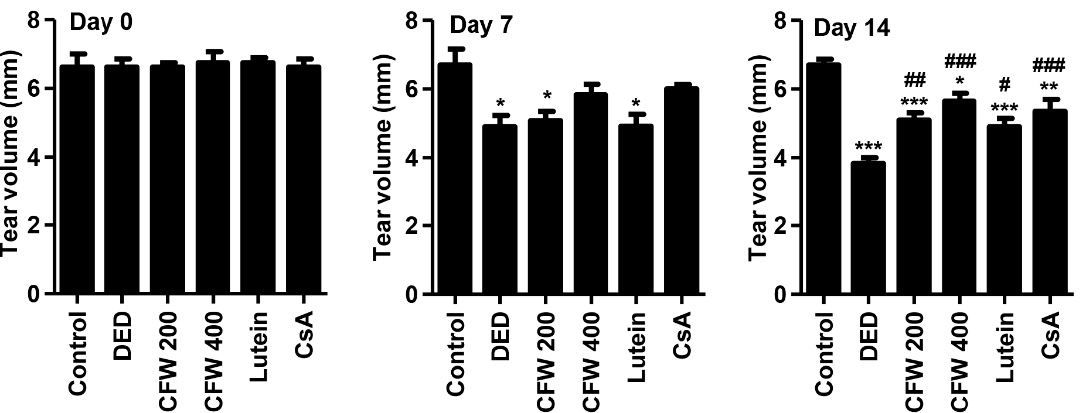
Figure 1. Effect of oral supplements of CFW on tear secretion after topical exposure to PM 2.5 in SD rats. On days 0, 7, and 14, tear volume was determined using phenol red tear threads and the length of color-changed thread was measured. The data are expressed as the means ± standard deviation ( n = 5). * p < 0.05, ** p < 0.01, and *** p < 0.001 compared to the control group. # p < 0.05, ## p < 0.01, and ### p < 0.001 compared to the PM 2.5 -induced DED group.